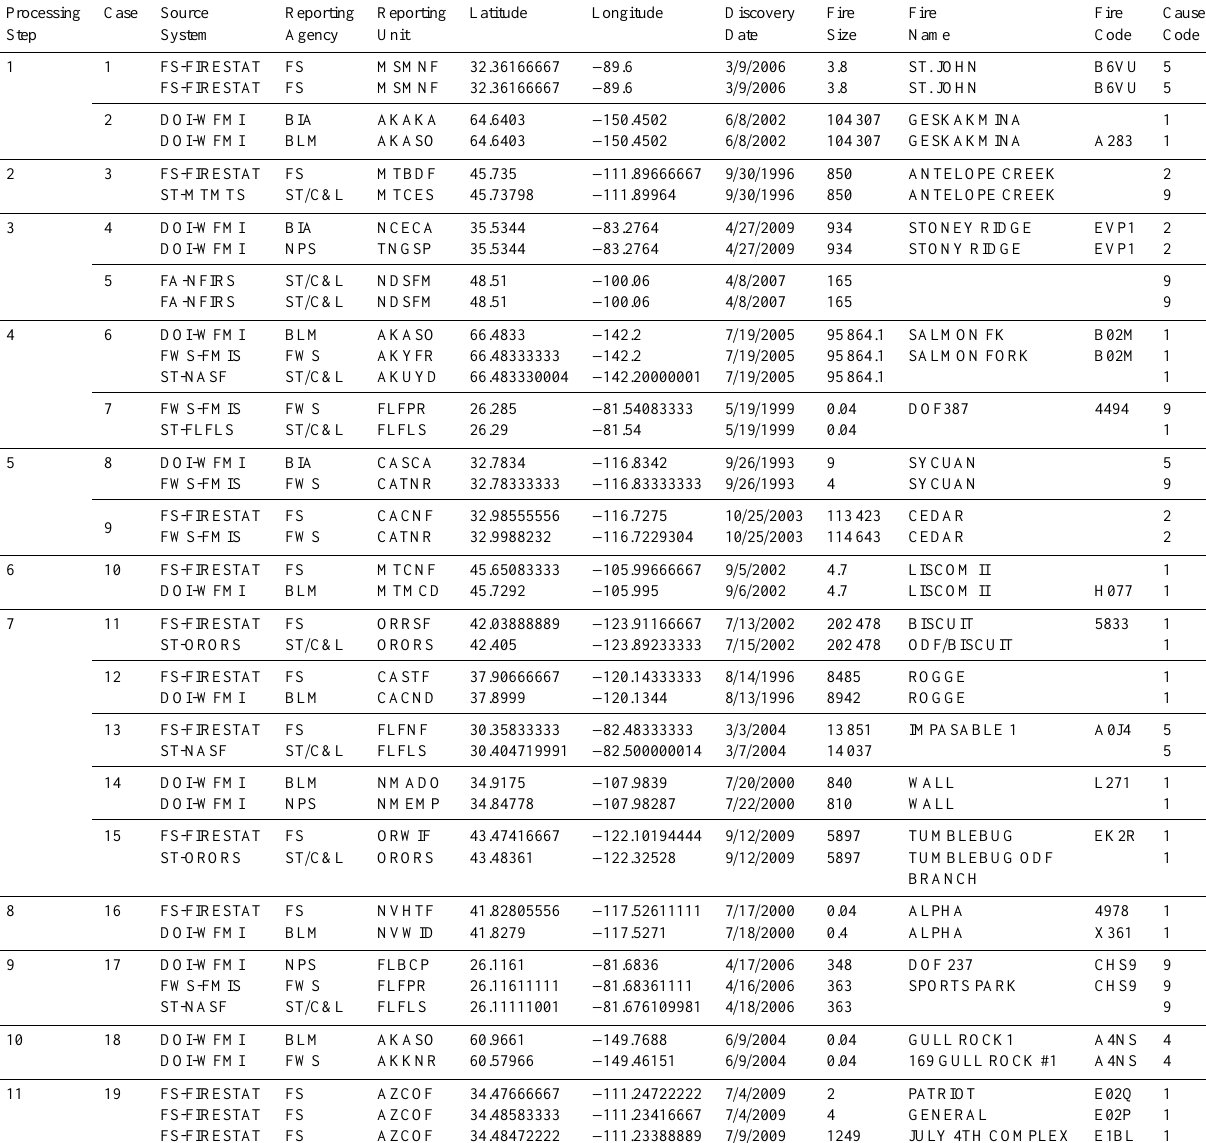
Table 7. Example cases of redundant records from the fire-reporting systems and steps in FPA FOD processing during which the records were flagged and all but one were removed from the final database. Fire size, shown here in hectares, is reported in the FPA FOD in acres, per the NWCG